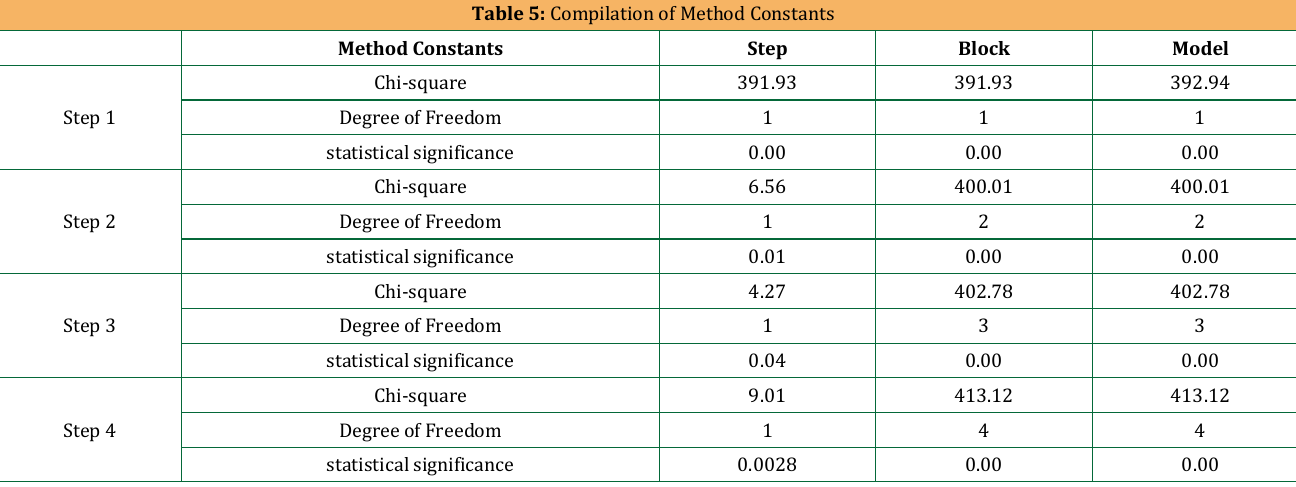
Table 5: Compilation of Method Constants